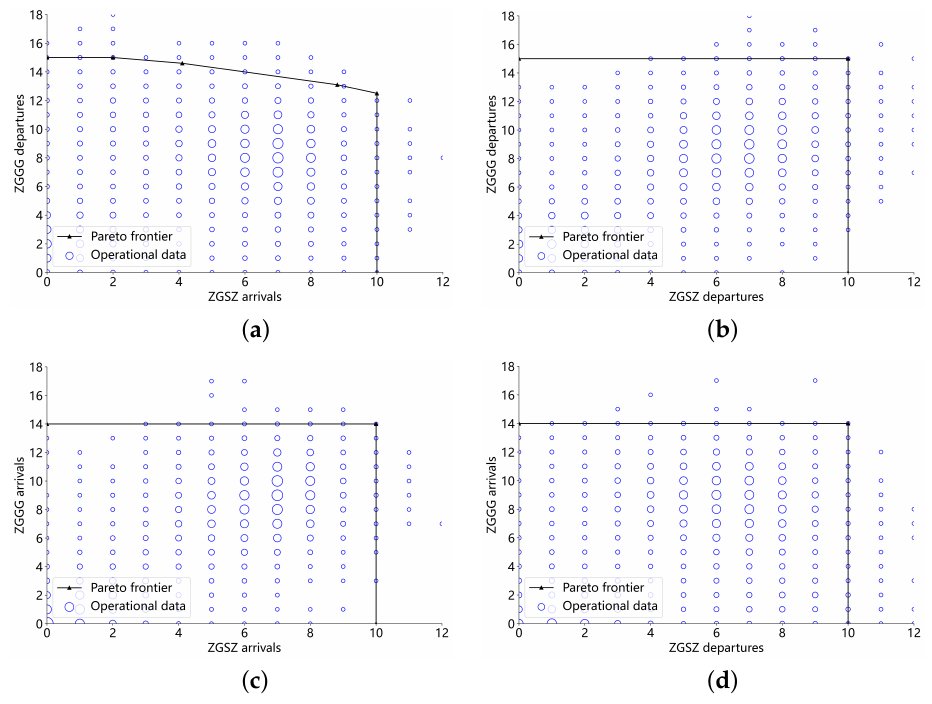
Figure 5. Airport capacity coverage curves. ( a ) Shenzhen (arr)–Guangzhou (dep); ( b ) Shenzhen (dep)–Guangzhou (dep); ( c ) Shenzhen (arr)–Guangzhou (arr); ( d ) Shenzhen (dep)–Guangzhou